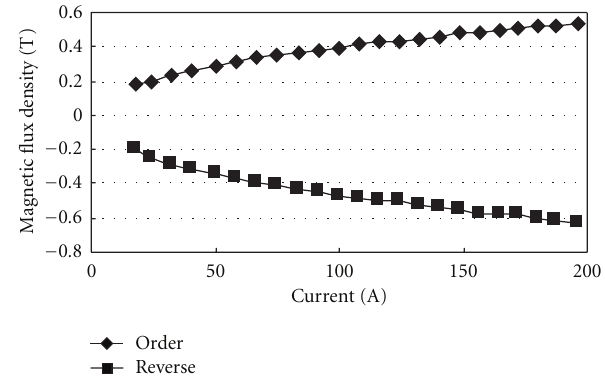
Figure 14: Measurement result of magnetic